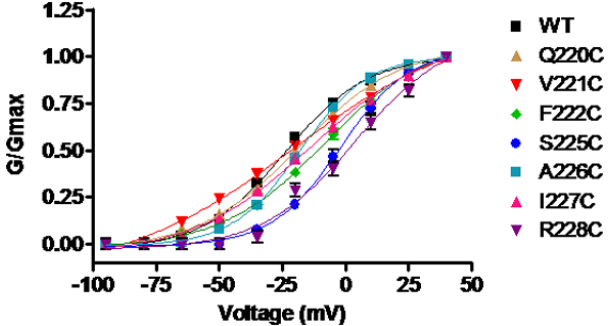
Figure 3. Conductance-voltage relations of WT Kv7.1 and mutants Q220C, V221C, F222C, S225C, A226C, I227C and R228C. Curves were fitted to one Boltzmann function. The following values were obtained: V 50 = 2 24.1 6 2.3 mV, s=16.3 6 2.1 mV (WT); V 50 = 2 18.7 6 1.5 mV, s=19.9 6 2.3 mV (Q220C); V 50 = 2 20.5 6 3.5 mV, s=33.8 6 7.1 mV (V221C); V 50 = 2 8.3 6 1.3 mV, s=20.5 6 2.2 mV (F222C);